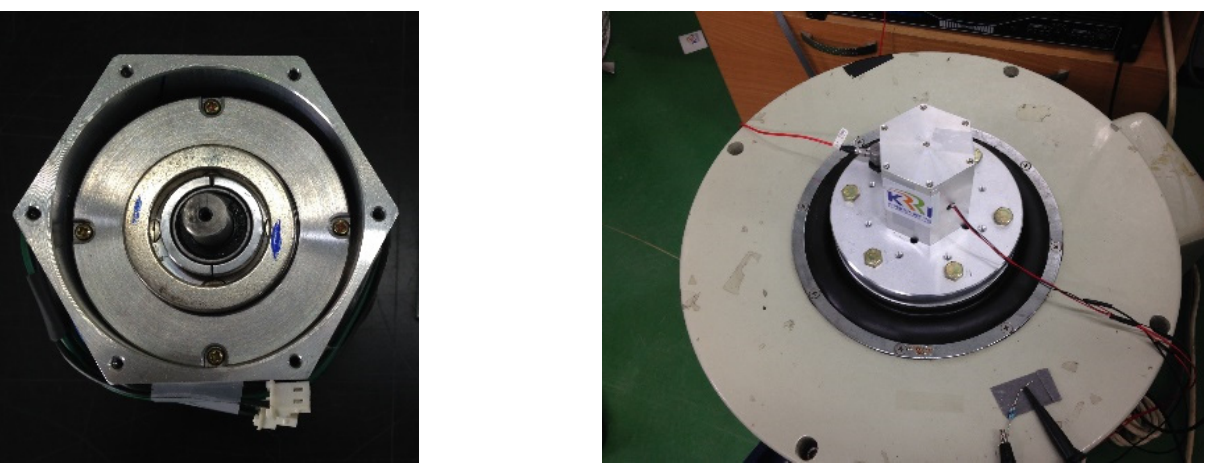
Figure 9. Magnetic spring vibration-energy-harvesting (VEH) device and magnetic spring VEH device on a vibrator in the laboratory.